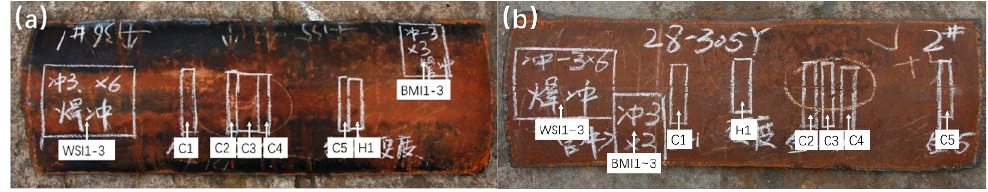
Figure 2. Schematic of sampling positions of cracking pipes ( a ) 1# and ( b ) 2#.